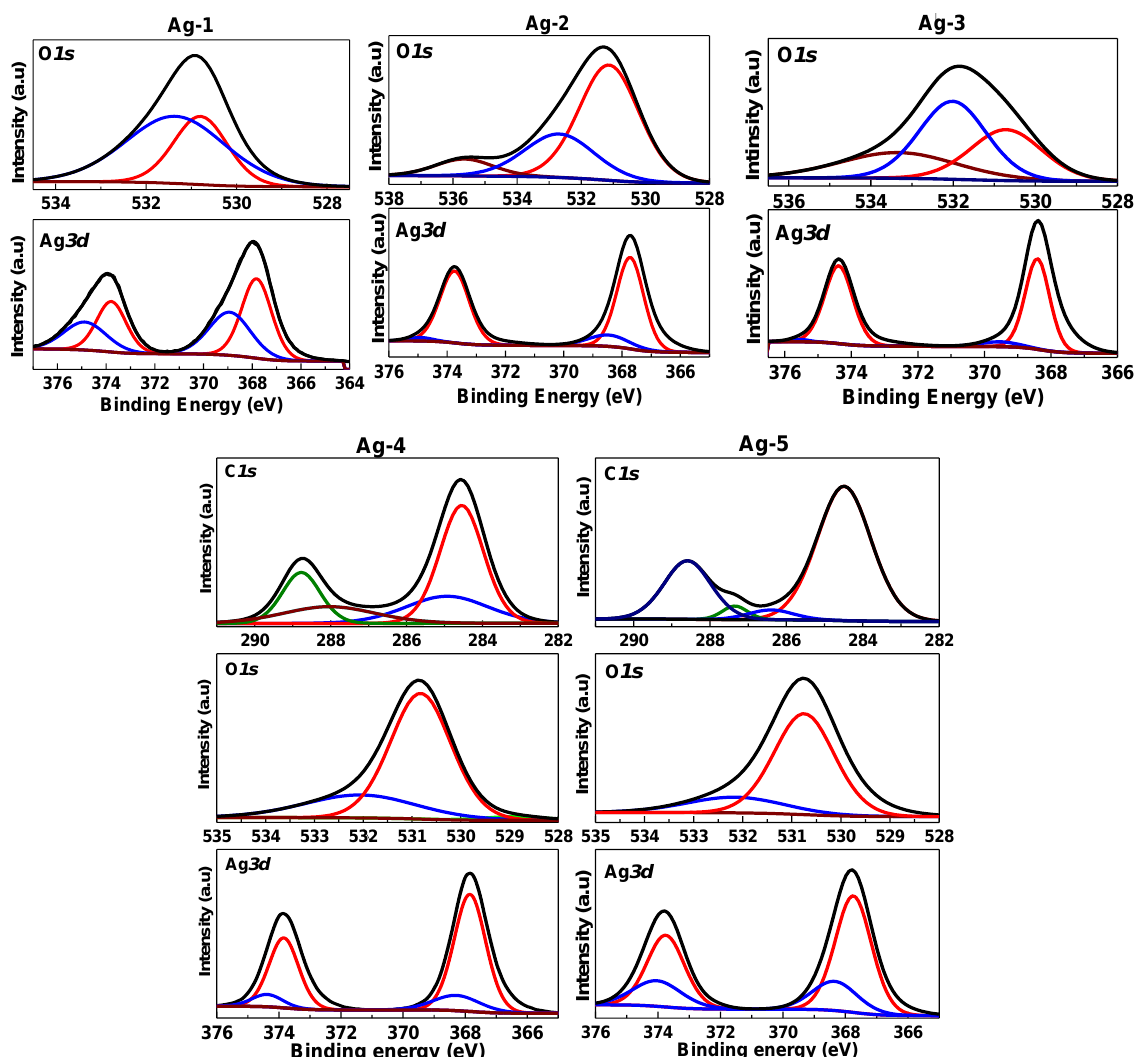
Figure 6. Deconvoluted XPS spectra for synthesized Ag-containing nanomaterials .